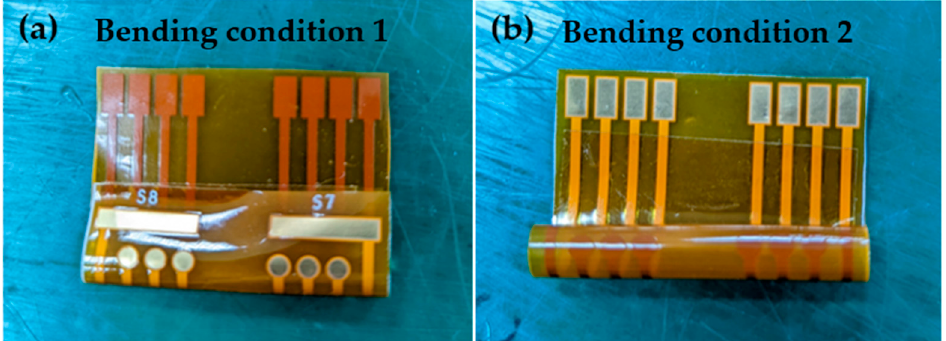
Figure 11. The photographs of the sensors ( a ) after being bent 180 degrees backward with a bending radius of 1 cm and ( b ) after being bent 360 degrees forward with a bending radius of 0.5 cm.